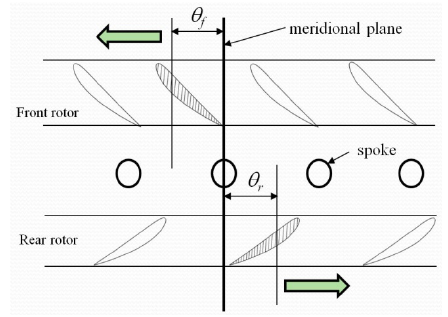
Figure 16. The schematic diagram of rotating angle.